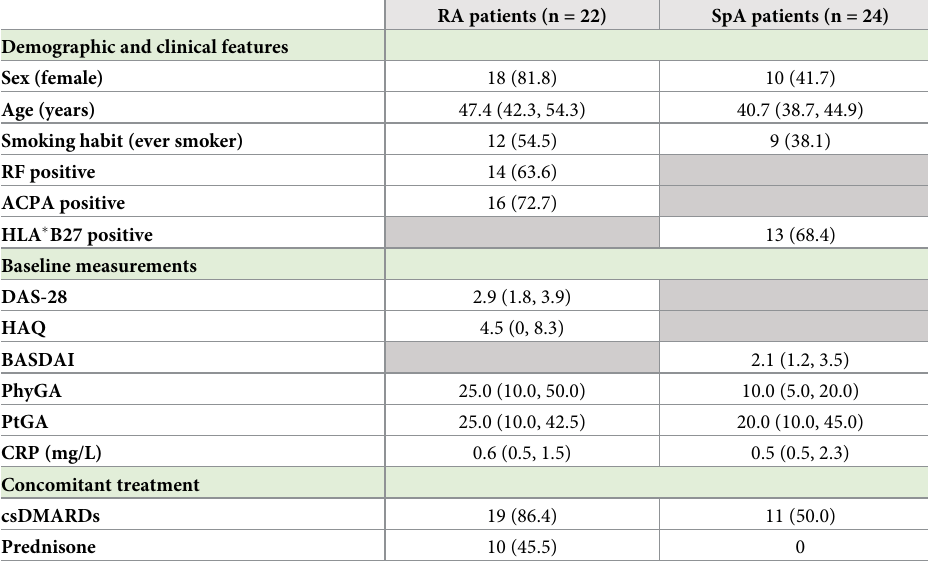
Table 1. Clinical characteristics stratified by disease at digital solution baseline.